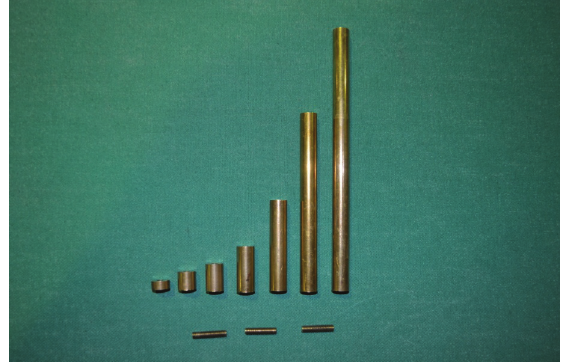
Fig. 2. The elements of underwater section, from left hand side; 5mm, 10mm, 15mm, 25mm, 50mm, 100mm and 150mm; They are attached with the screw shown